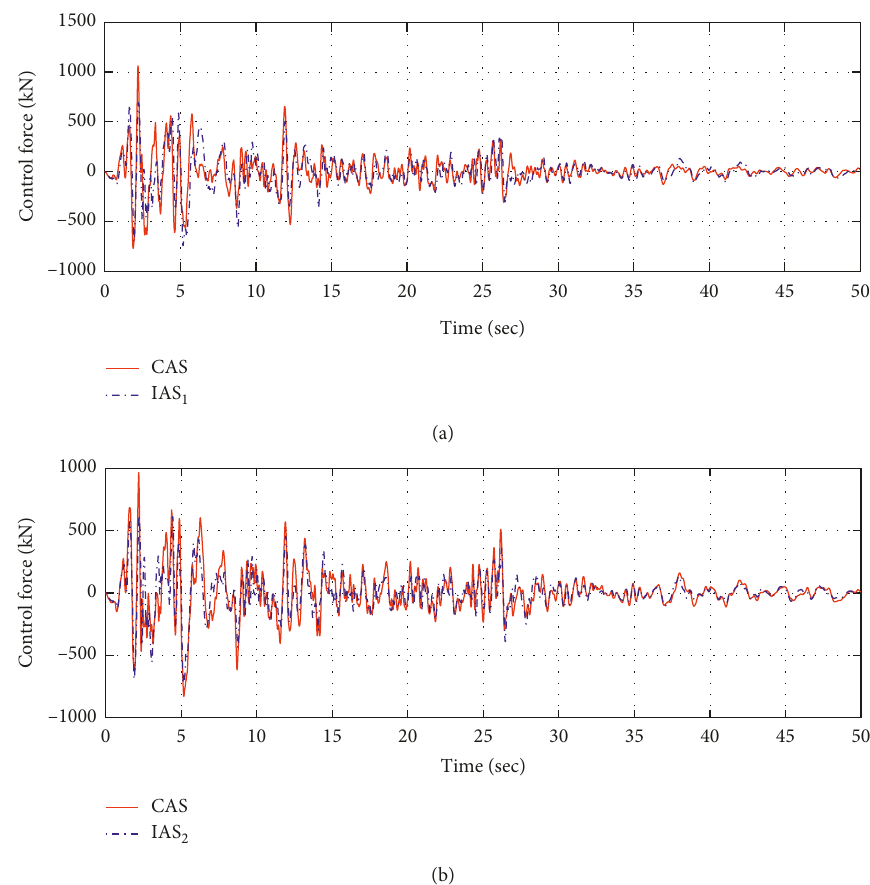
Figure 8: Comparison of control forces exerted by IAS and CAS against El Centro earthquakes. (a) Building 1. (b) Building 2.